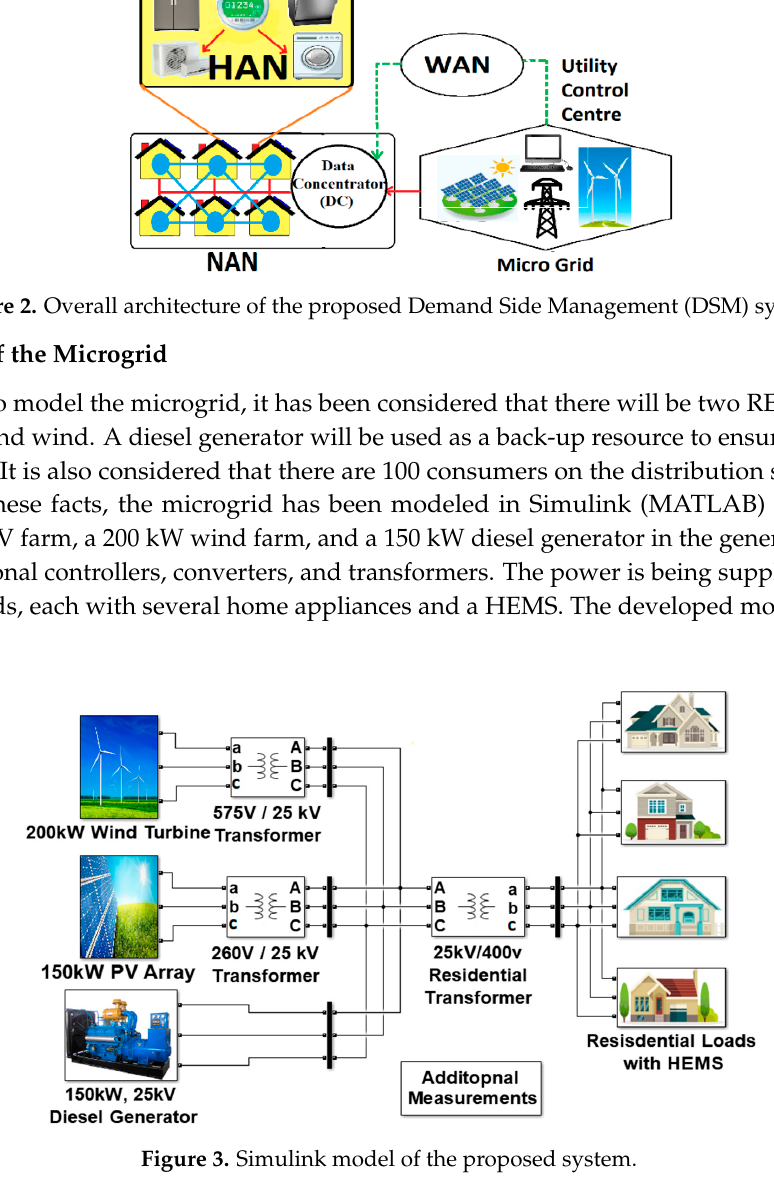
Figure 3. Simulink model of the proposed system.